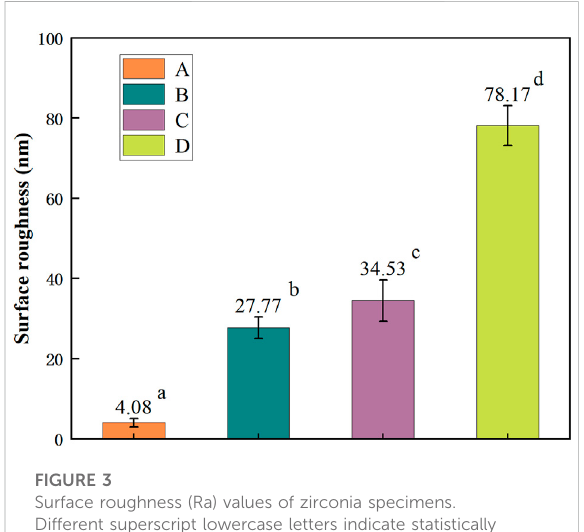
FIGURE 4 XRD patterns of zirconia specimens (T indicates the tetragonal zirconia